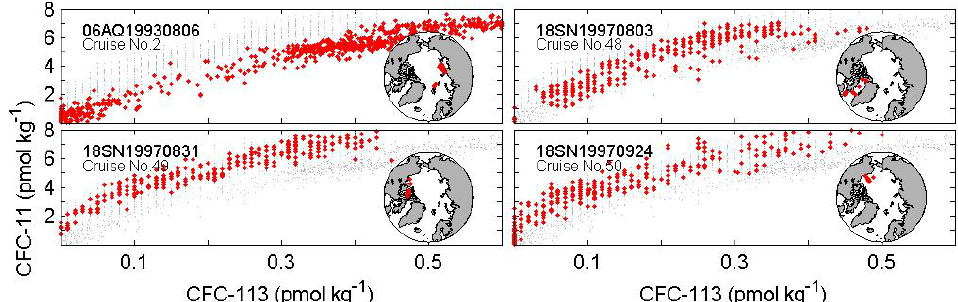
Figure 16. CFC-11 vs. CFC-113. See Fig. 11 for